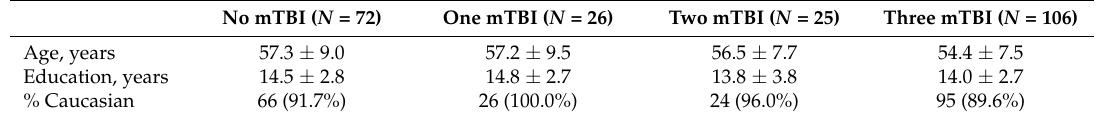
Table 1. Participant Characteristics by Mild Traumatic Brain Injury (mTBI)